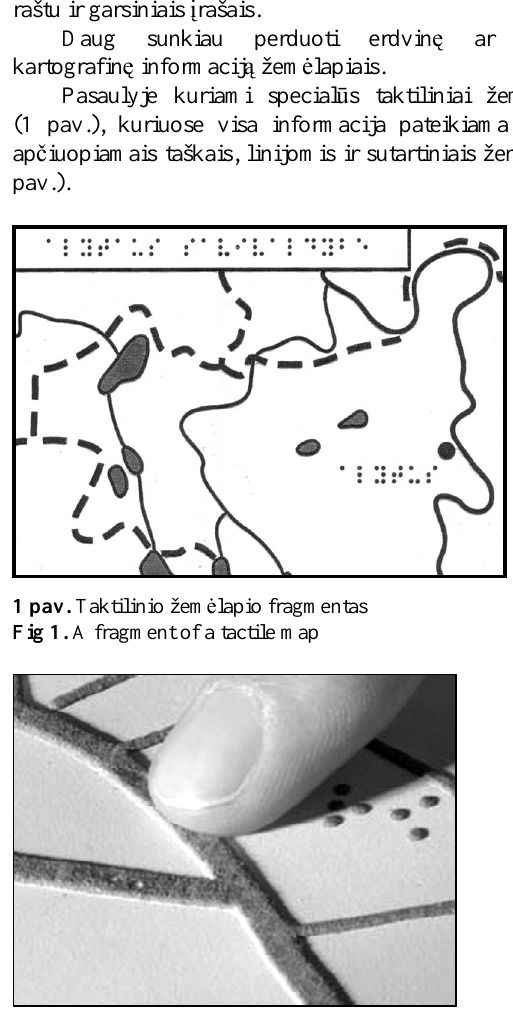
Fig 2. A special type of paper is used for the tactile